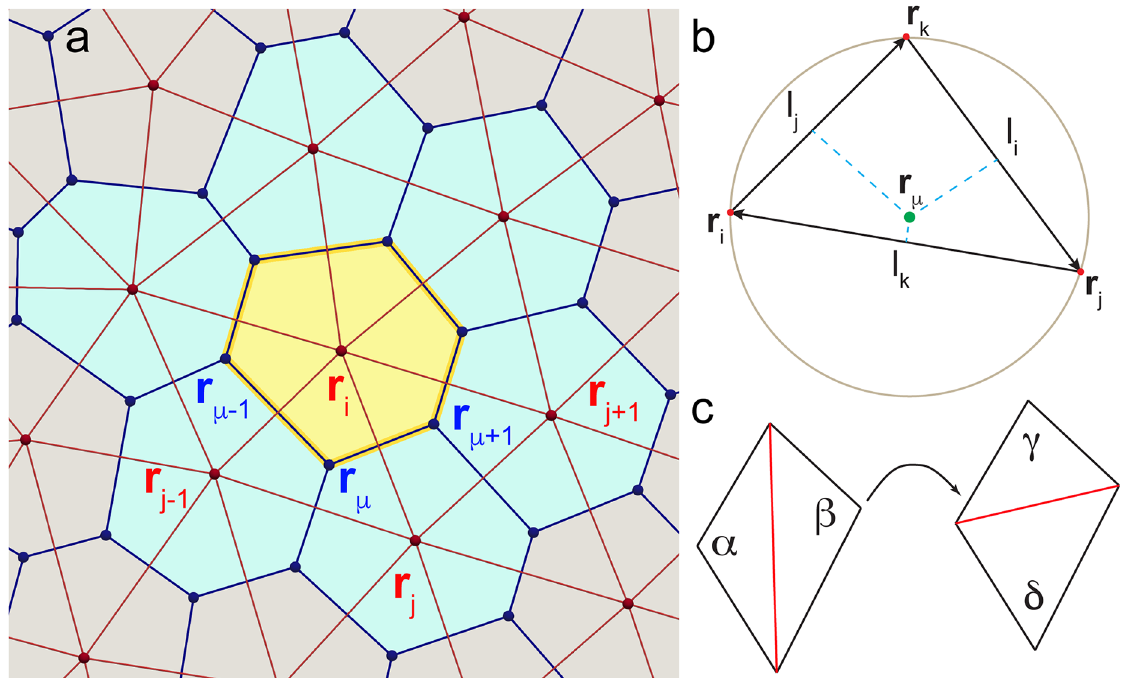
Fig 2. (a) Two coordinaterepresentations dual to each other. In the AVM we track particlesthat correspond to cell centres (red dots). Particles form a Delaunaytriangulation(red lines) and their positionsare labeledwith vectors carrying Latin indices. The dual of the Delaunaytriangulationis a Voronoitessellation, with each Voronoi cell (a shadedpolygon)representing an actual cell. Cell edges are marked by blue lines. Positionsof the vertices (blue dots) of the dual mesh are denotedby Greek indices. (b) Positionof the circumcenter r μ of the trianglewith corners r i , r j and r k . (c) The edge flip move is at the core of the equiangulation procedure. If the sum of the anglesoppositeto the red edge exceeds α + β > 180˚ the edge is “flipped”.As the result, the sum of the anglesoppositeto the new edge is less than 180˚, i.e., γ + δ < 180˚. Note that this edgeflip is local and only affects one Voronoi edge(i.e., cell junction).Therefore, edge flips can only affect the local connectivity of four cells (see also, Fig